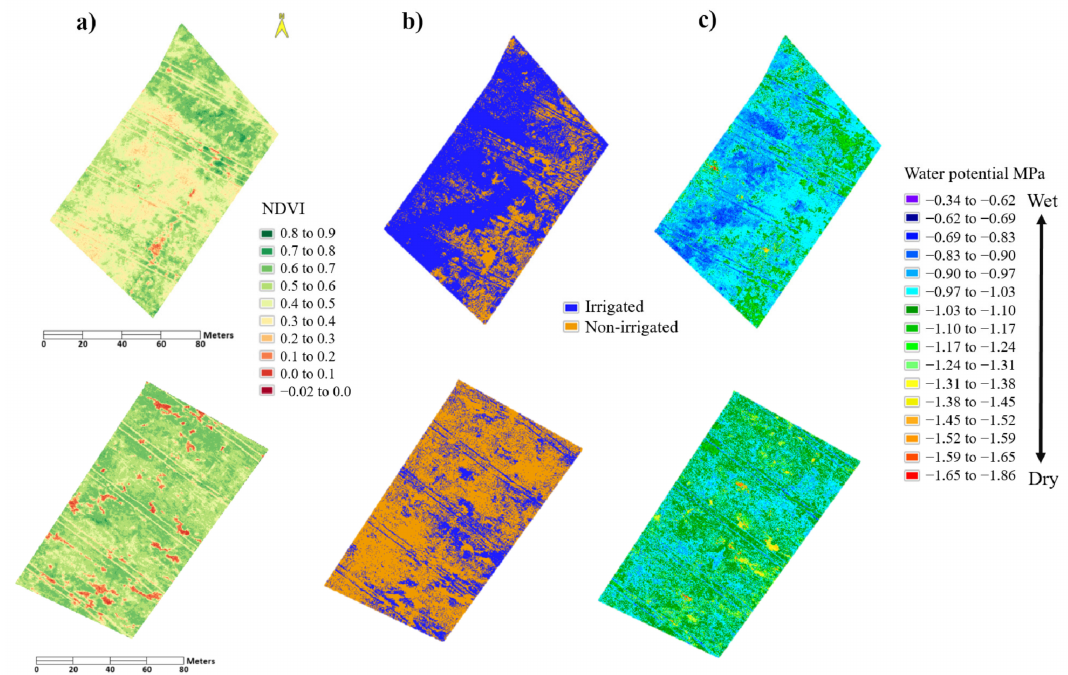
Figure 5. Processed scene images of irrigated (top images) and non-irrigated (bottom images) field sections over peak bloom. ( a ) Normalized difference vegetation index (NDVI) images of scenes. ( b ) Classified images of irrigated and non-irrigated scenes. ( c ) Predicted images of water potential.